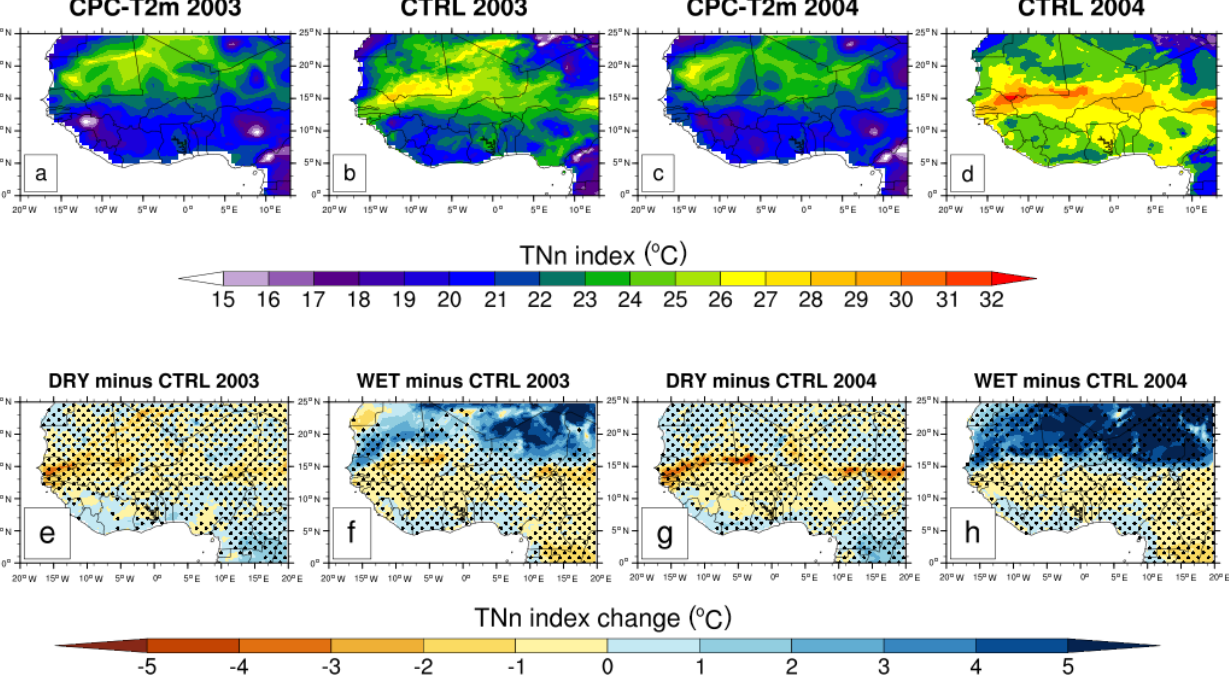
Figure 18. Same as Fig. 14 but for the TNn